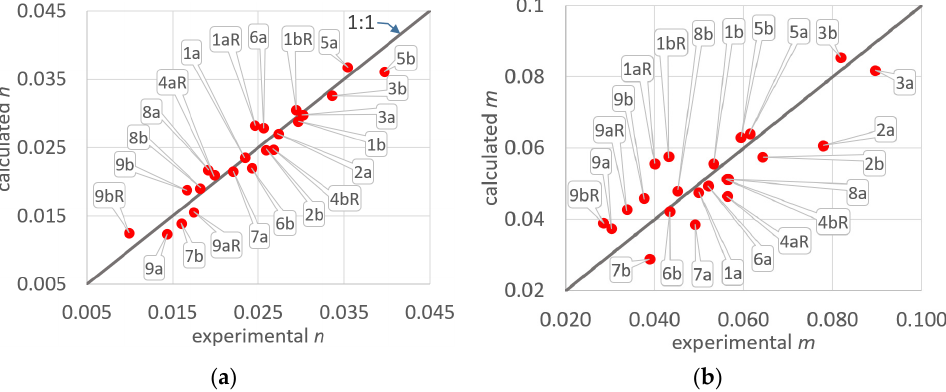
Figure 5. For the 22 runs, comparison between the parameters obtained using the ordinary least squares method applied to the experimental pairs ( E , t ) and those calculated ( a ) using Equation (12) for the n parameter and ( b ) using Equation (13) for the m parameter.